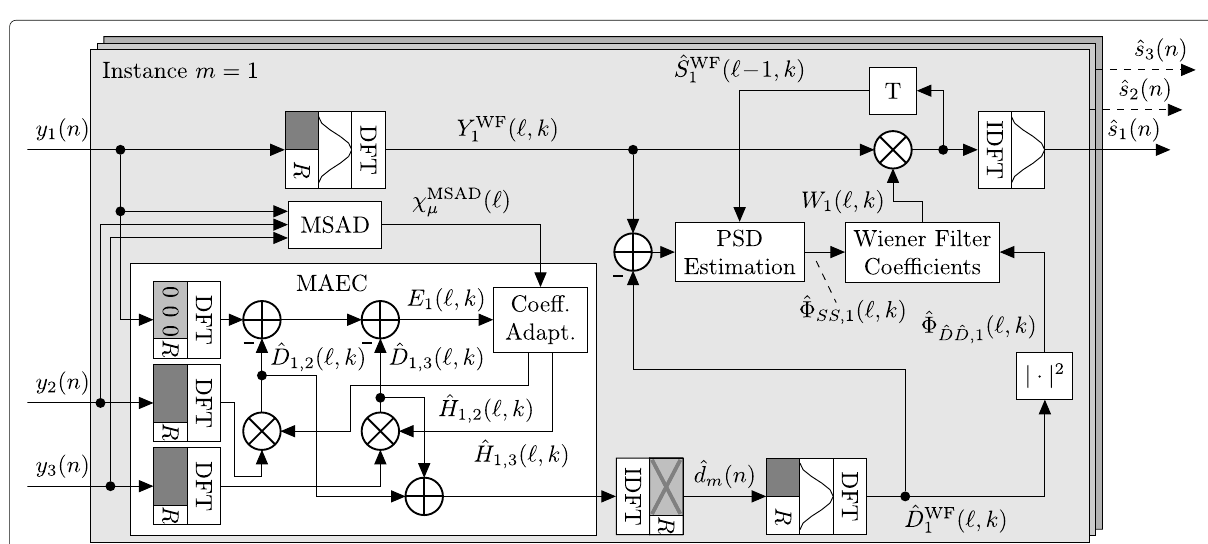
Fig. 6 Proposed multichannel Kalman-based Wiener filter (MKWF) for interferer reduction in channel m = 1. The box denotes the previous K − R and K WF − R samples in the buffer of the MAEC and WF, respectively; the elimination of K − R samples w.r.t. the OLS constraint, and the replacement of K − R samples by zeros. The inputs are changed accordingly to obtain ˆ s 2 ( n ) and ˆ s 3 ( n